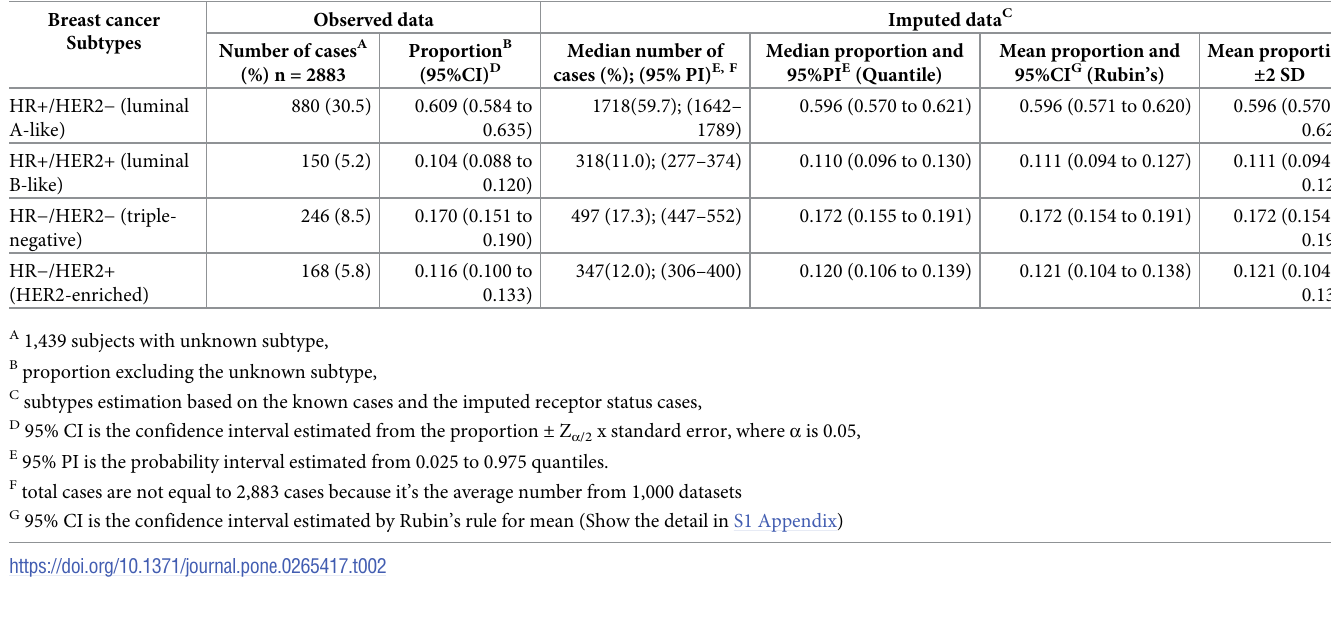
Table 2. The proportion of breast cancer subtypes and confidence/probability intervals among the observed and imputed datasets. Breast cancer